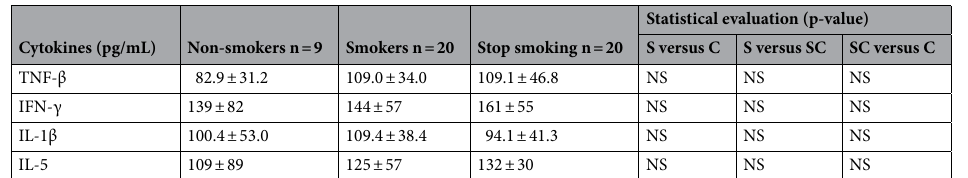
Table 5. The impact of smoking and smoking cessation on circulating cytokines. All data are presented as mean ± SD; TNF-β: tumour necrosis factor-beta; INF-γ: interferon-gamma; IL-1β: interlukin-1beta; IL-5: interleukin-5; C: Non-smokers; S: smokers; SC: 14 days smoking cessation; NS: not significant.